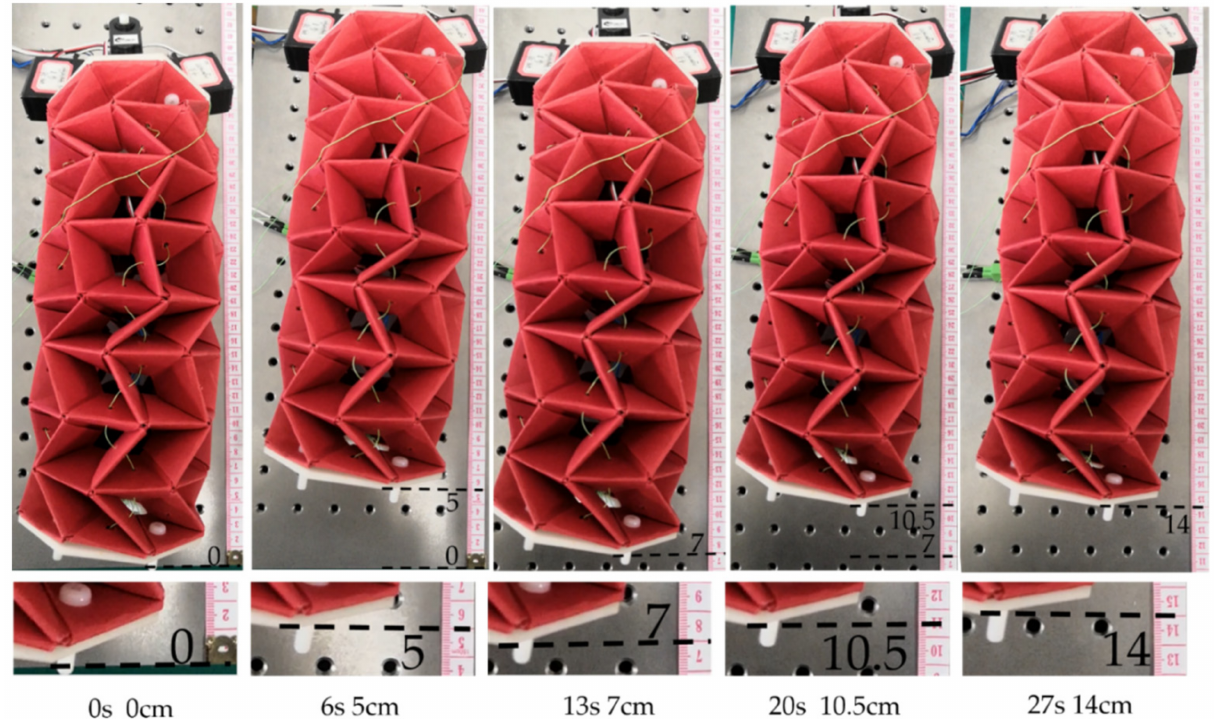
Figure 21. Top view of the forward motion of the origami crawling robot with electromagnetic sliding feet on an iron plane.